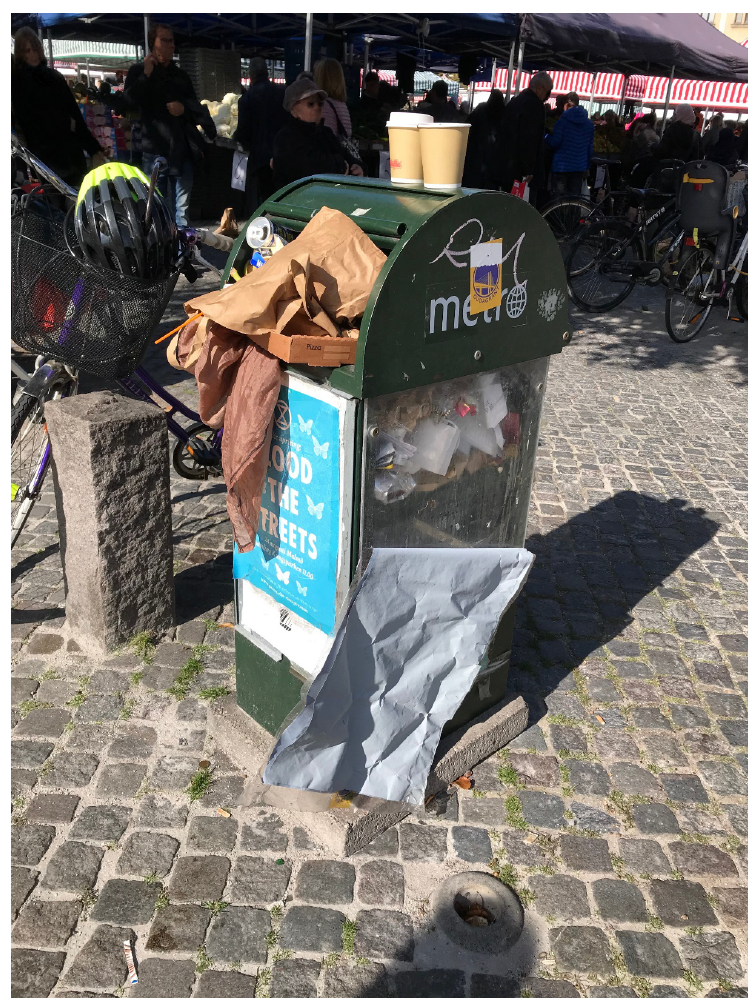
Figure 3. Newspaper box after the newspaper was cancelled, Malmö, Sweden. Source: Photo by author. A sub-type in the long tradition of drinking